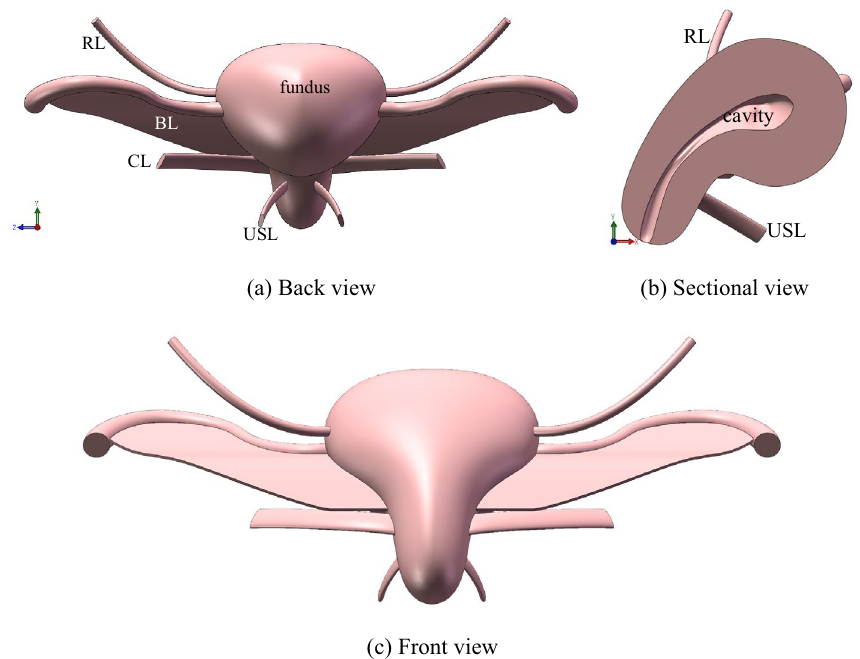
Figure 1. 3D model of uterus and its accessory ligaments. a Back view, b Sectional view. c Front view. (created by Solidworks 2018, https:// www. solid works. com/ zh-